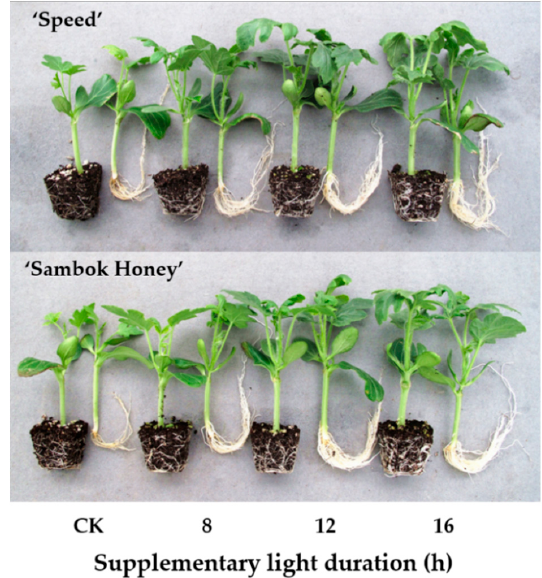
Figure 4. The effects of the supplementary light duration on the morphology of two cultivars of watermelon seedlings, ‘Speed’ and ‘Sambok Honey’, grafted onto ‘RS Dongjanggun’ bottle gourd rootstocks, after 10 days of supplementary light treatments.